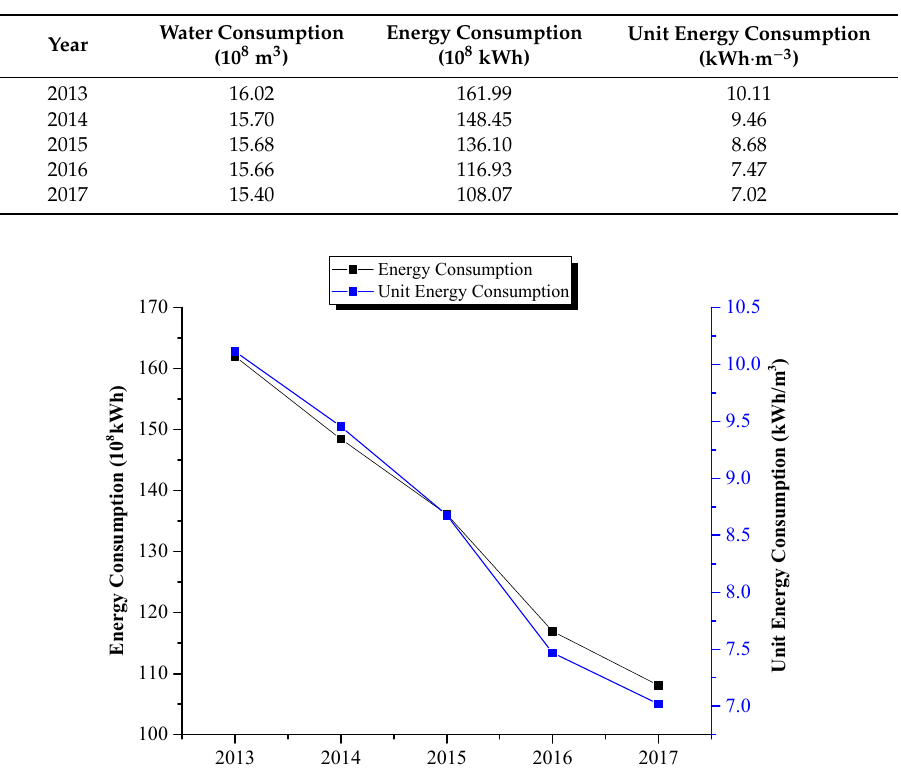
Figure 5. Year-by year changes in energy consumed during the life cycle of water resources in Ordos, China.